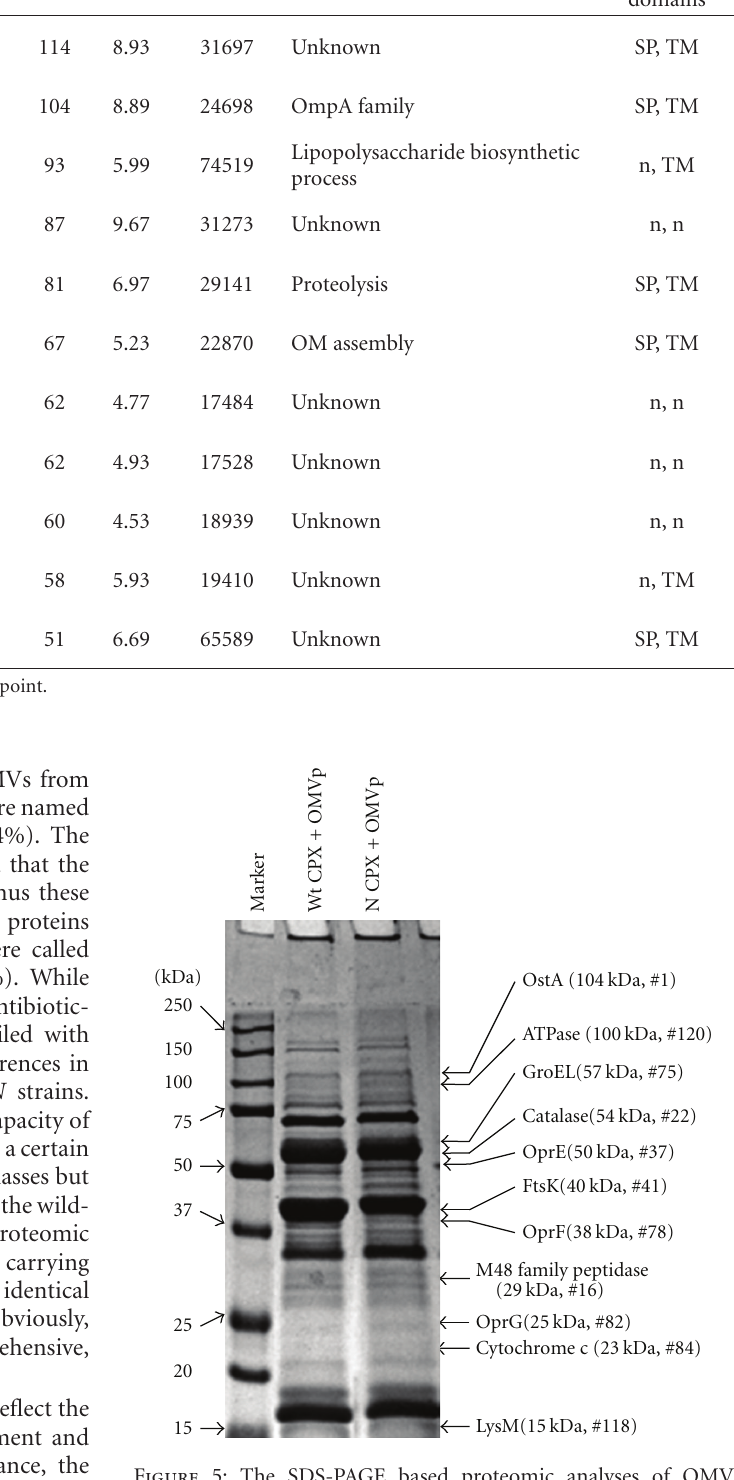
Figure 5: The SDS-PAGE based proteomic analyses of OMV proteins from the SOS-induced and the un-induced cells. CPX, ciprofloxacin. N, LexA noncleavable; and wt, wild-type. Illustrated to the right were the proteins known to associate with OMVs, cytotoxicity, and SOS (See text and Tables for